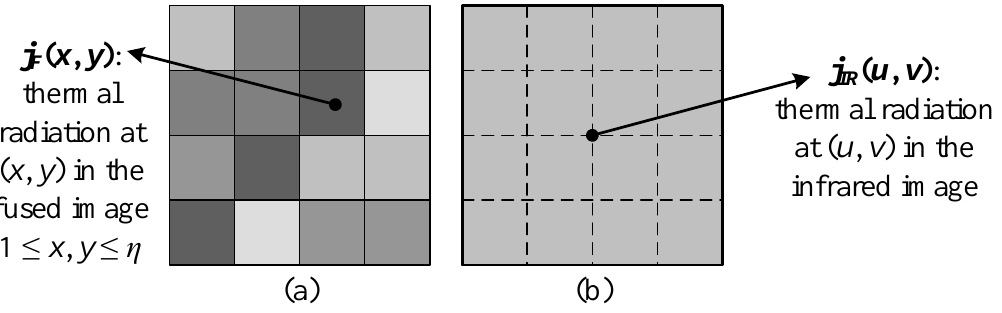
Figure 7. Illustration of the thermal energy deviation. ( a ) A η × η window in the fused image. In this case, η = 4. ( b ) One pixel in the low-resolution IR image. It is interpolated to the same scale as (a). The thermal energy deviation characterizes the difference of radiation energy in these η × η areas between fused image and IR